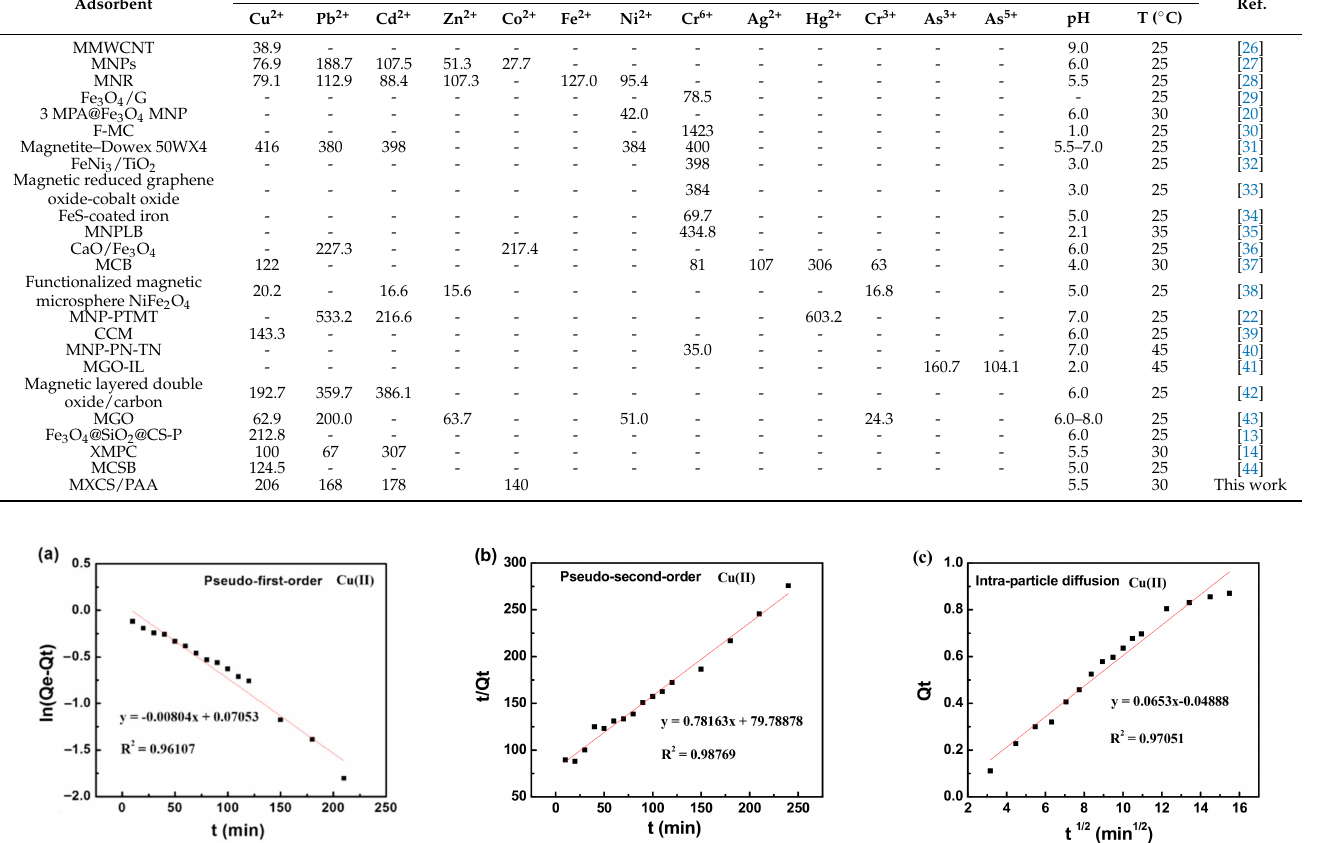
Figure 6. Adsorption kinetic for Cu(II) ions on MXCS/PAA, ( a ) pseudo-first-order kinetic model, ( b ) pseudo-second-order kinetic model, and ( c ) intra-particle diffusion model.